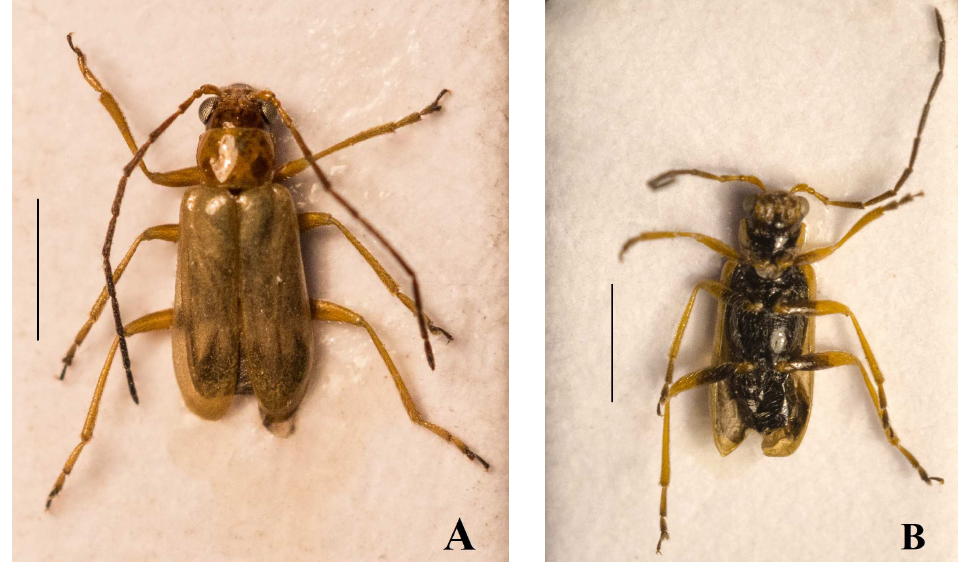
F IGURE 2. Dorsal (A) and ventral (B) view of Luperus perlucidus Iablokoff-Khnzorian,